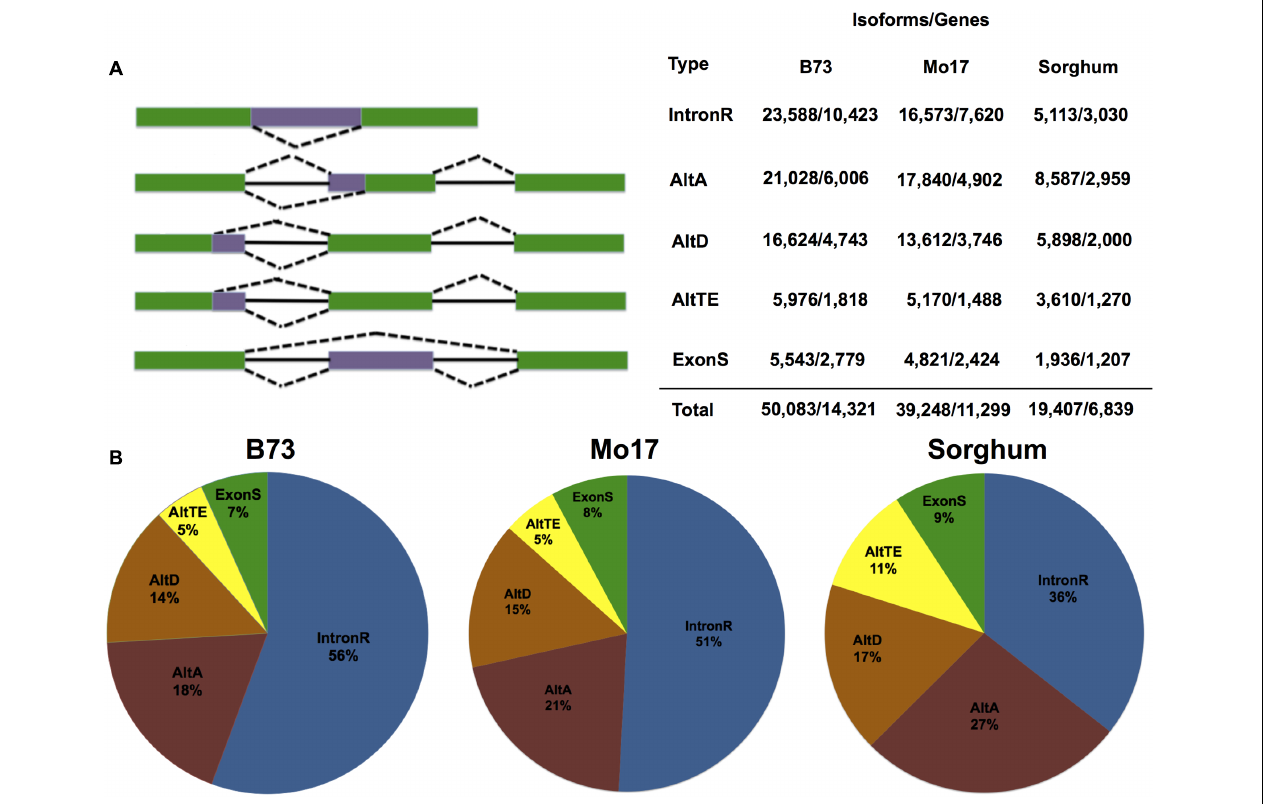
FIGURE 1 | Genome-wide AS event distributions and patterns. (A) Graphic of event types followed by the number of AS isoforms and the number of genes that demonstrate this type of splicing event in maize inbred lines B73 and Mo17, and sorghum. (B) Proportions of alternative splicing events (alternative acceptor, AltA; alternative donor, AltD; Exon Skipping, ExonS; Intron Retention, IntronR; alternate terminal exon, AltTE) found in maize inbred lines B73 and Mo17, and